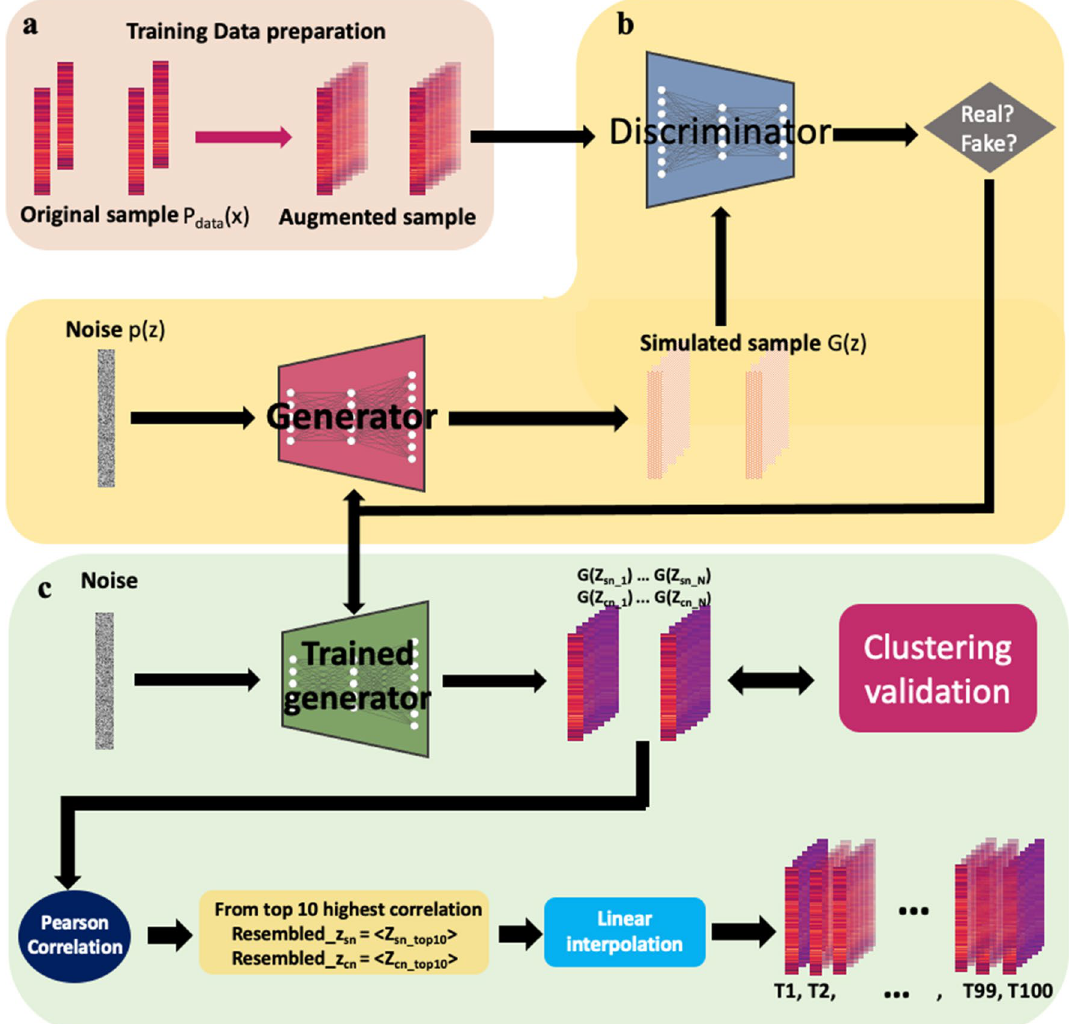
Figure 1. WGAN workflow. ( a ) Training Data preparation for GAN training. Simple tenfold linear augmentation method is applied. ( b ) GAN training framework structure ( c ) Generating fined time interval data using trained network. G represents generator. z is noise vector. T1–T100 represents time point from 1 to